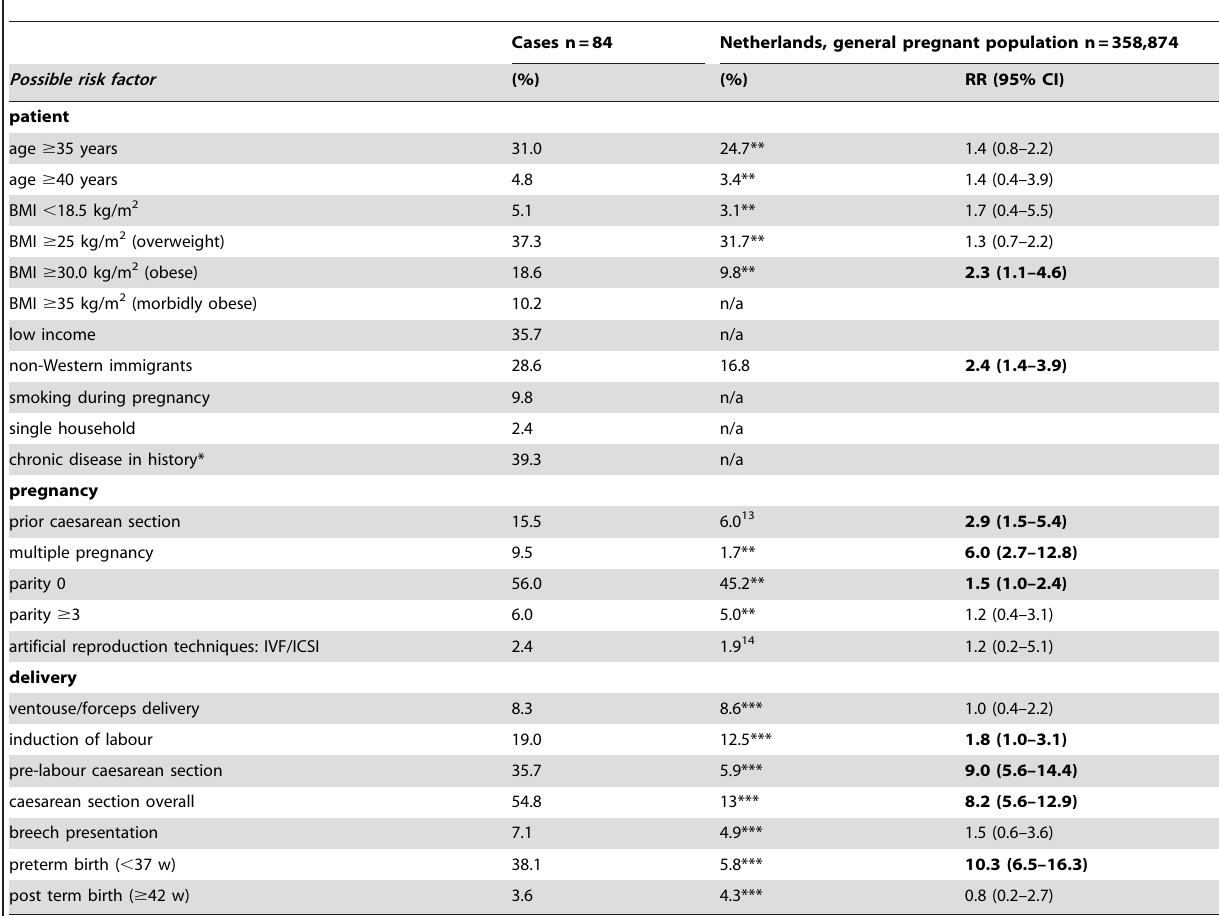
Table 4. Comparison of possible risk factors for developing severe maternal morbidity and mortality caused by cardiovascular disease between cases and the general pregnant